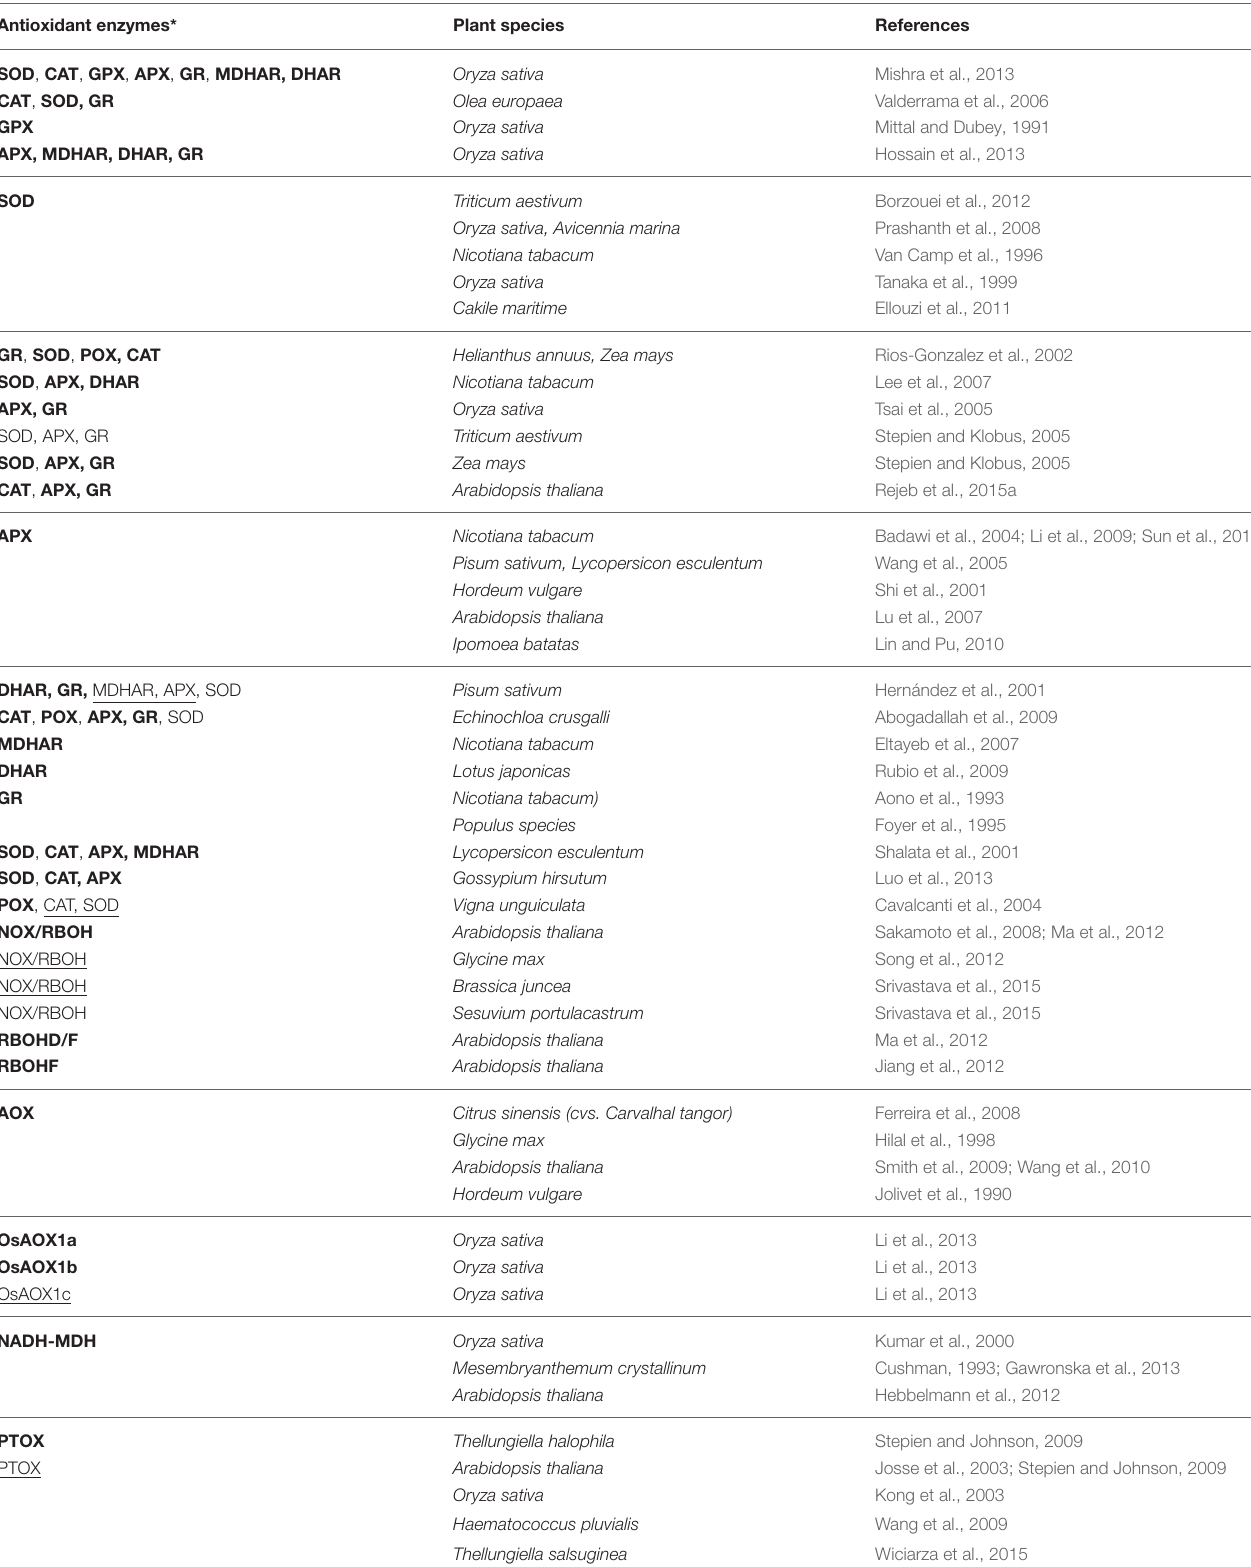
TABLE 2 | Antioxidant enzymes reported to be regulated in plants under salinity